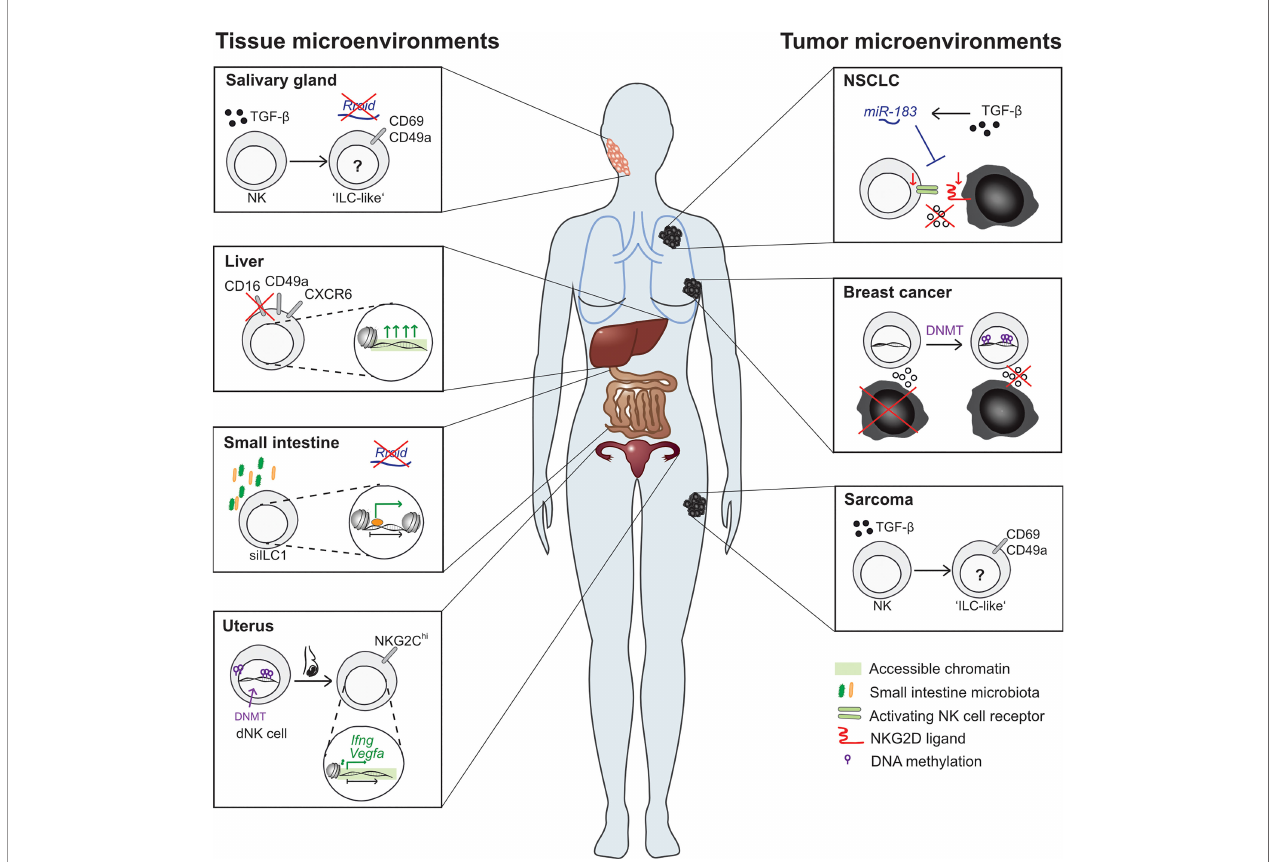
FIGURE 3 | Effects of different tissue microenvironments on NK cell and ILC epigenetic features. Tissue microenvironments (left side): NK cells in different tissues display strikingly unique features. For example, NK cell numbers in the salivary gland and small intestine are independent of the presence of the lnc-RNA Rroid , which is required for NK cell and ILC1 development in other tissues. Moreover, the enrichment of TGF- b in the salivary gland microenvironment leads to the conversion of NK cells into an ILC1-like phenotype. In the liver, tissue-resident NK cells display a unique phenotype: CXCR6-expressing NK cells are most abundantly found in the liver as compared to other tissues and display singular functional features. In human livers, a CD49a + CD16 - NK cell subsets is marked by disparate chromatin accessibility patterns which regulate antigen-speci fi c cytotoxicity. Within the small intestine, NK cells and ILC display unique phenotypic and transcriptional features, separating them from NK cells from other tissues. The role of local microbiota in shaping this phenotype is underlined by the fact that antibiotic treatment leads to marked alterations in the epigenetic landscape of small intestine ILC1. In the uterus, a functionally and phenotypically unique subset of NK cells with reduced cytotoxicity is found. Decidual NK cells (dNK cells) show divergent DNA methylation patterns and pregnancy leads to the development of a NKG2C hi NK cells subset with increased chromatin accessibility at the Ifng and Vegfa locus. Tumor microenvironments (right side): Malignant tissues also provide severely altered microenvironments, which affect NK cells on multiple levels. NSCLC-in fi ltrating NK cells display decreased DAP12-expression, caused by TGF- b induced miR-183. MiR-183 targets both DAP12 in NK cells, leading to a decrease in activating receptor signaling and cytotoxicity, and NKG2D ligands in cancer cells, leading to a further decrease in NK cell recognition. Contact of NK cells with breast cancer cells leads to a functional switch in NK cells from tumoricidal to metastasis-promoting, which was shown to be associated with DNMT upregulation. In MCA sarcomas, high levels of TGF- b leads to a conversion of NK cells into ILC1-like cells with lower anti-tumoral